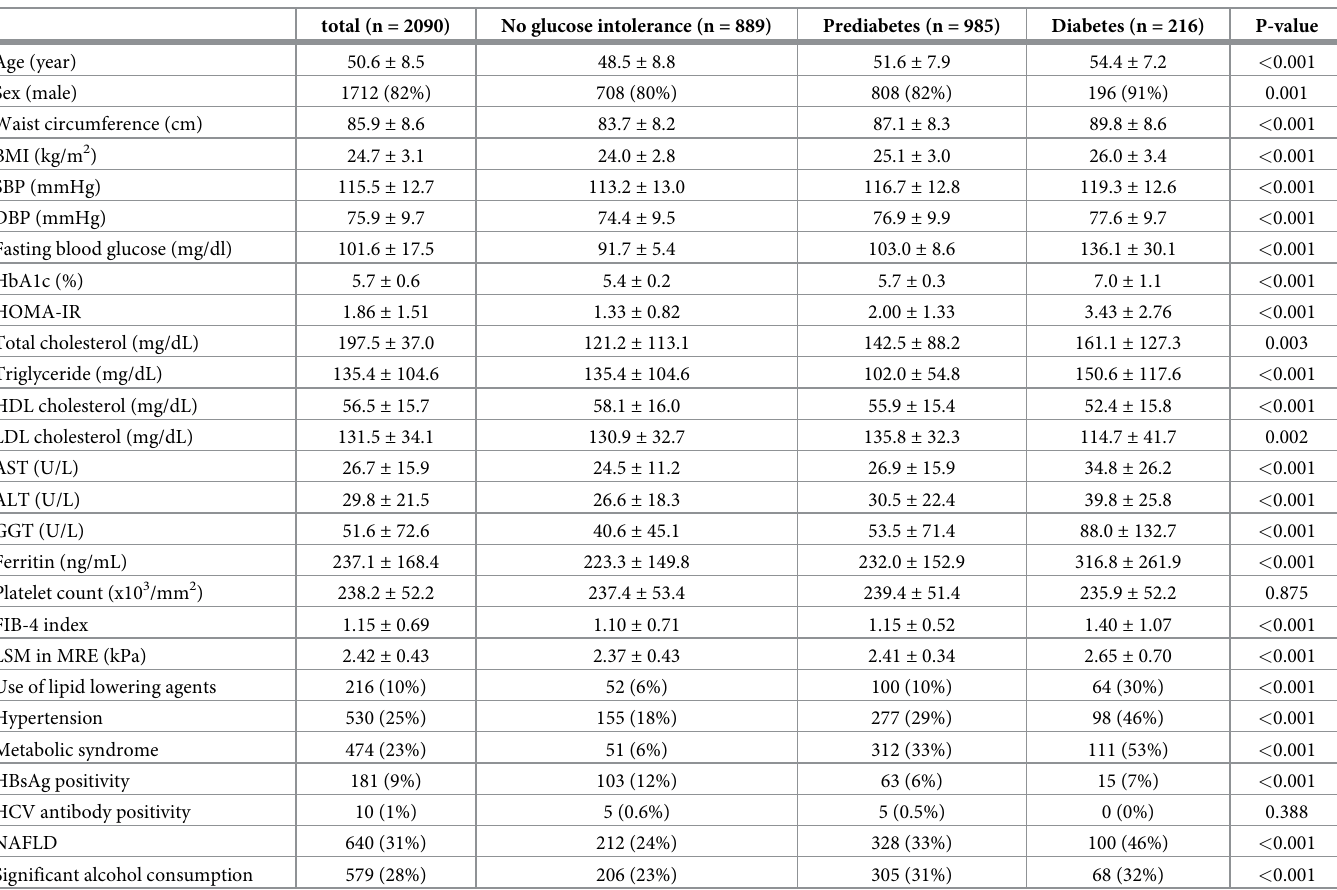
Table 1. Baseline characteristics of study participants (n =